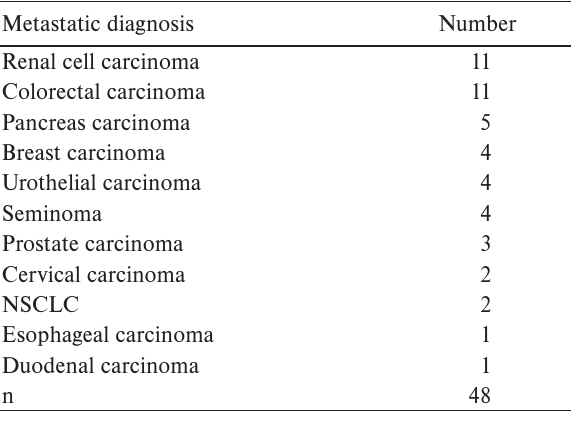
Table 2. The number of diagnosed metastatic